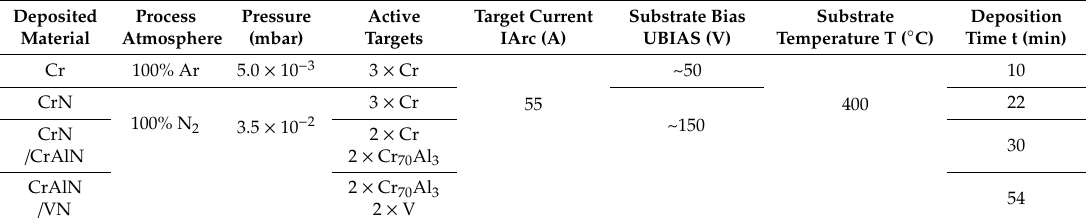
Table 1. Deposition parameters of Cr / n x (CrN) / (CrN / CrAlN) / m x (CrAlN / VN) multilayers.